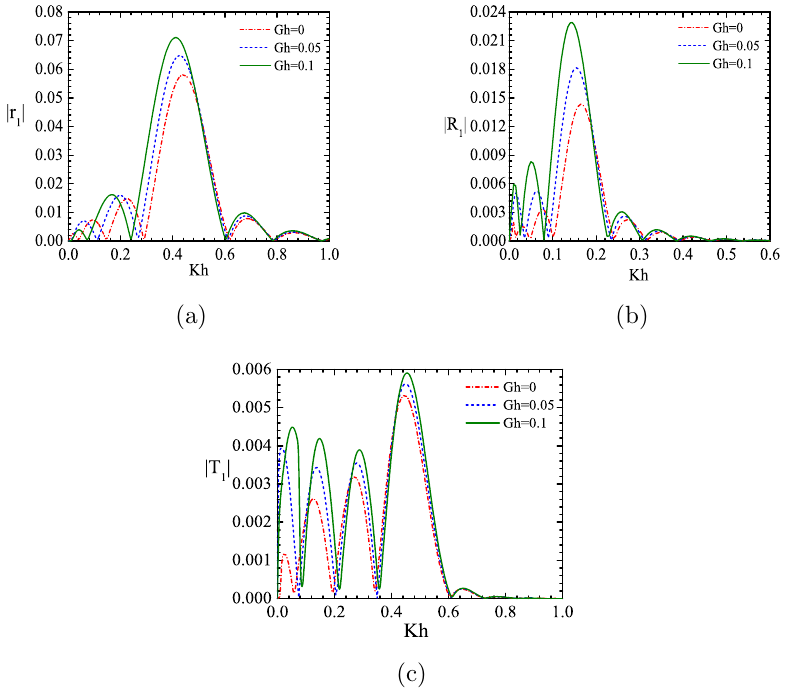
Figure 8. Coefficients due to incident wave of mode λ 1 in (a) | r 1 | ; (b) | R 1 | ; (c) | T 1 | for ρ = 0 . 5, H/h = 2, M/h 2 = 0 . 2, γh = 1, a/h = 0 . 1, m = 5 ,n =